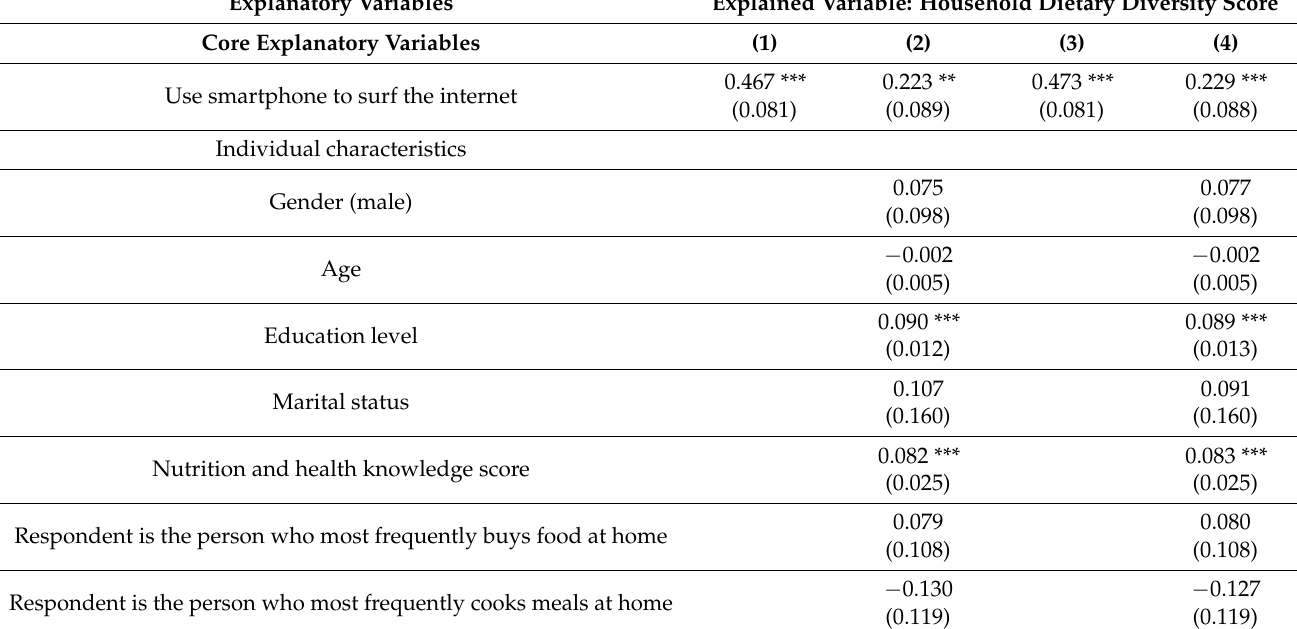
Table 3. Baseline